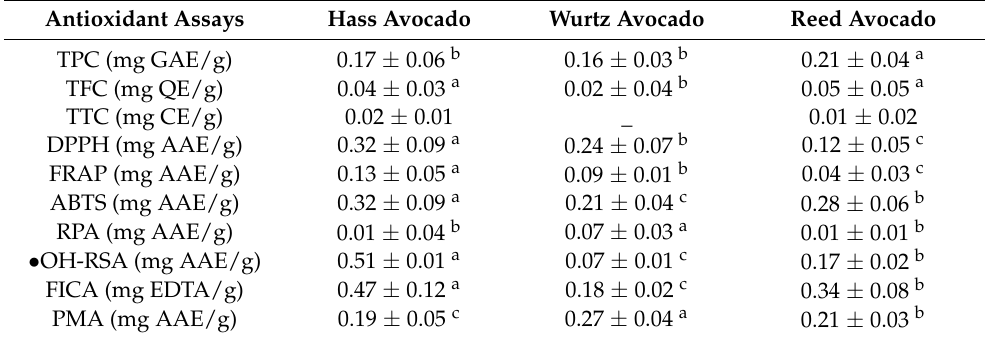
Table 1. Polyphenol content estimation and antioxidant capacity of rejected avocados. Antioxidant